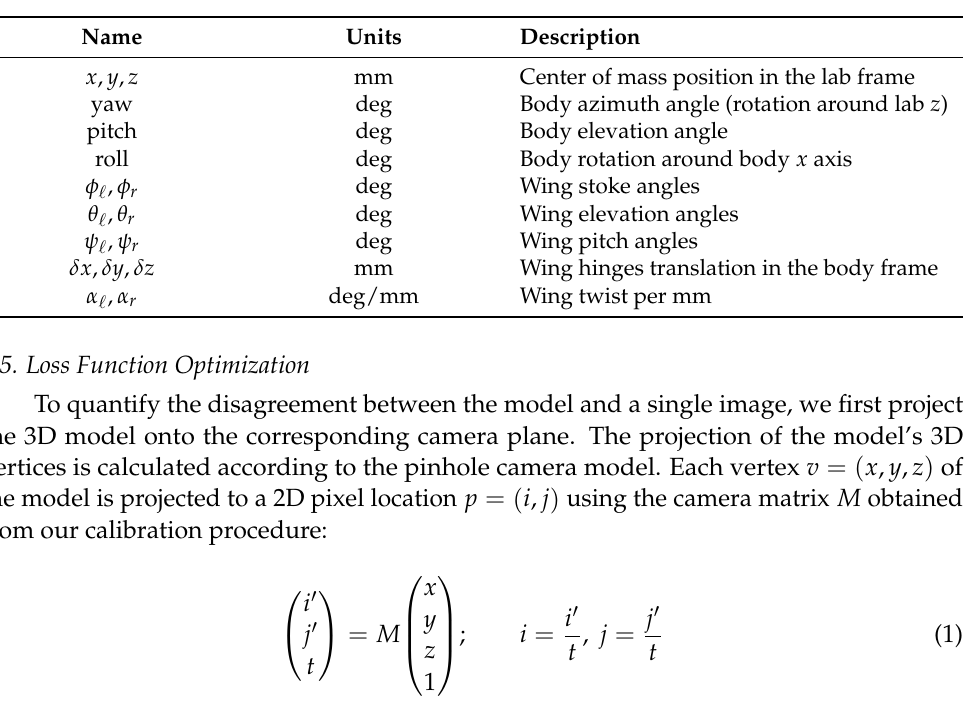
Table 1. Definition of model degrees of freedom.